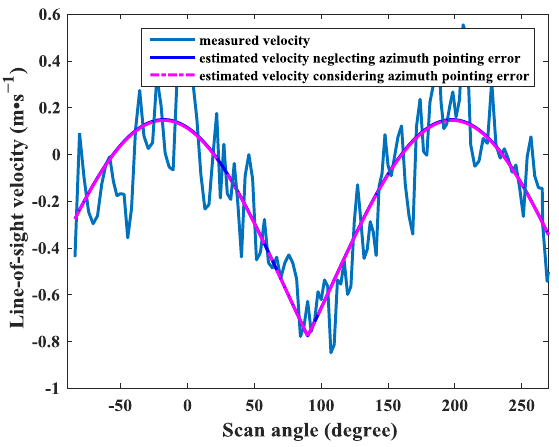
Figure 9. Curves of estimated line-of-sight velocities.